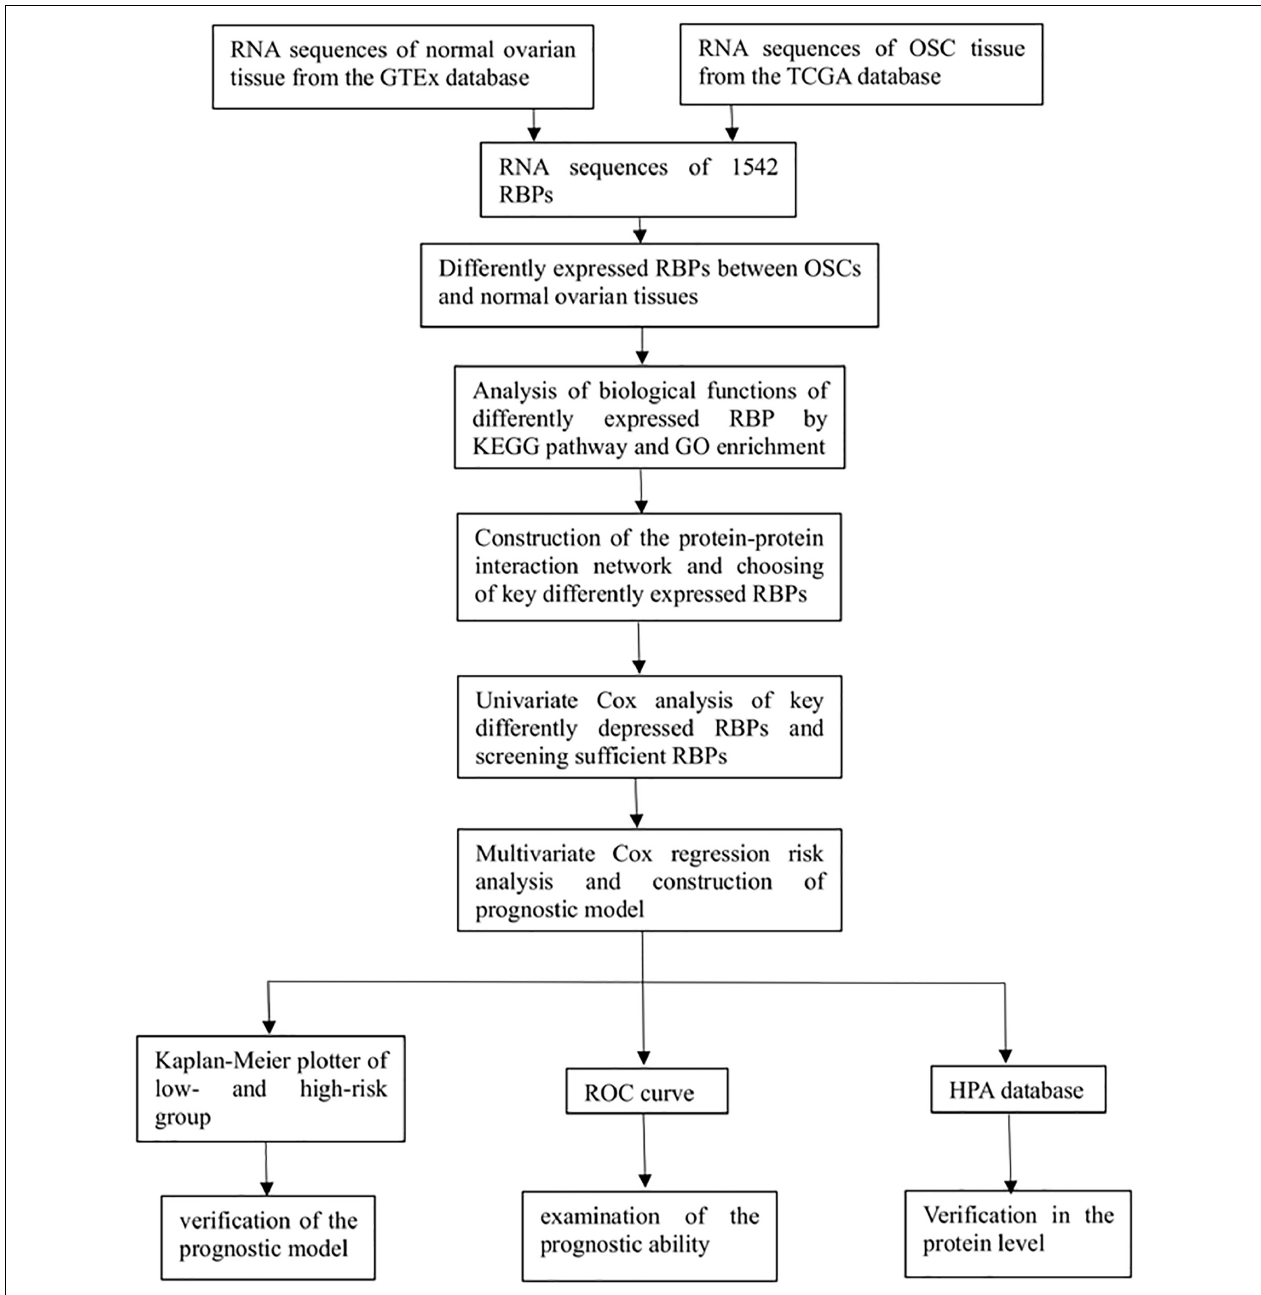
FIGURE 1 | Flow diagram of this study.